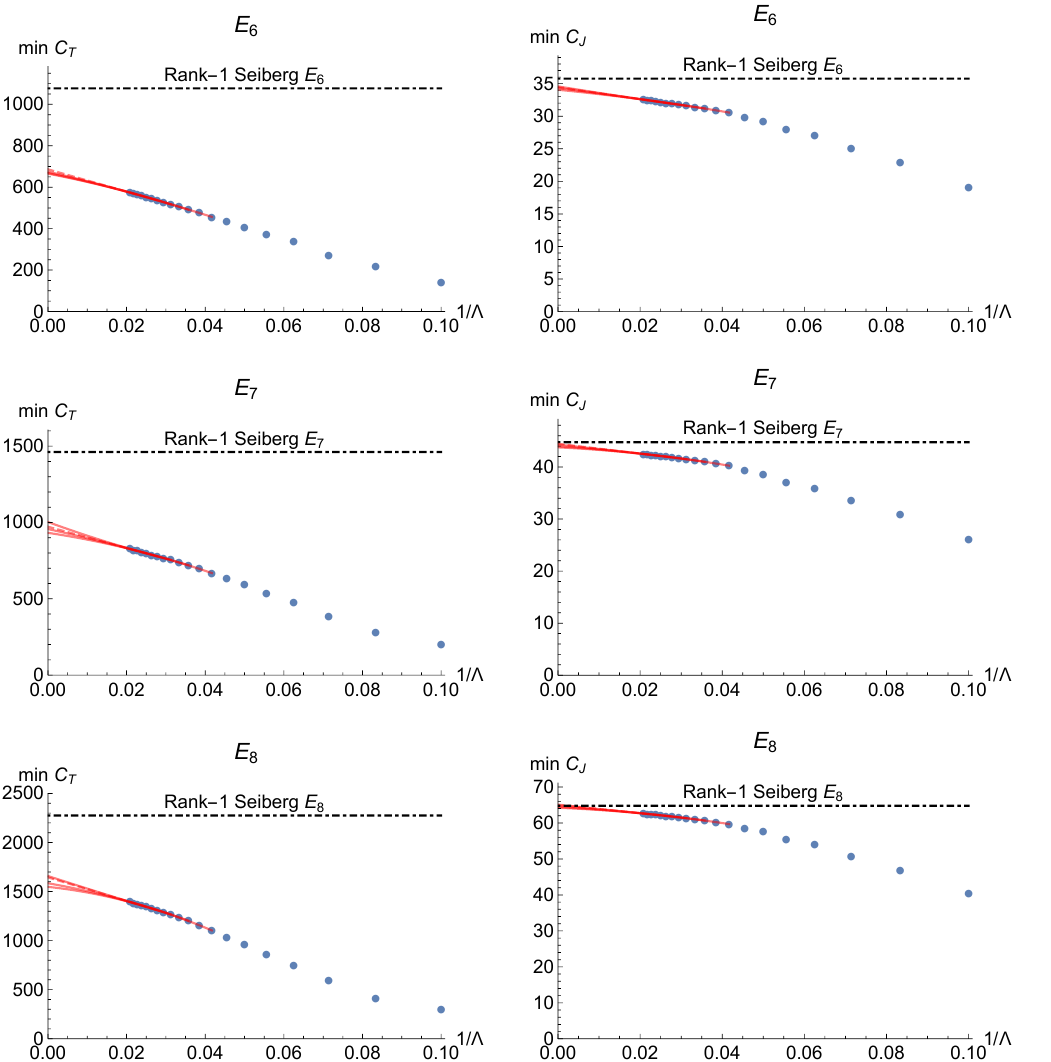
Figure 9. Lower bounds on C T (left) and C J (right) for interacting theories with E 6 , E 7 , and E 8 (cid:13)avor groups, at various derivative orders (cid:3) and extrapolated to in(cid:12)nite order using the quadratic ansatz (5.21) (solid) and the linear ansatz (5.22) (dashed). Also shown are the four-instanton values of C T and C J in the rank-one Seiberg exceptional theories (dotdashed).